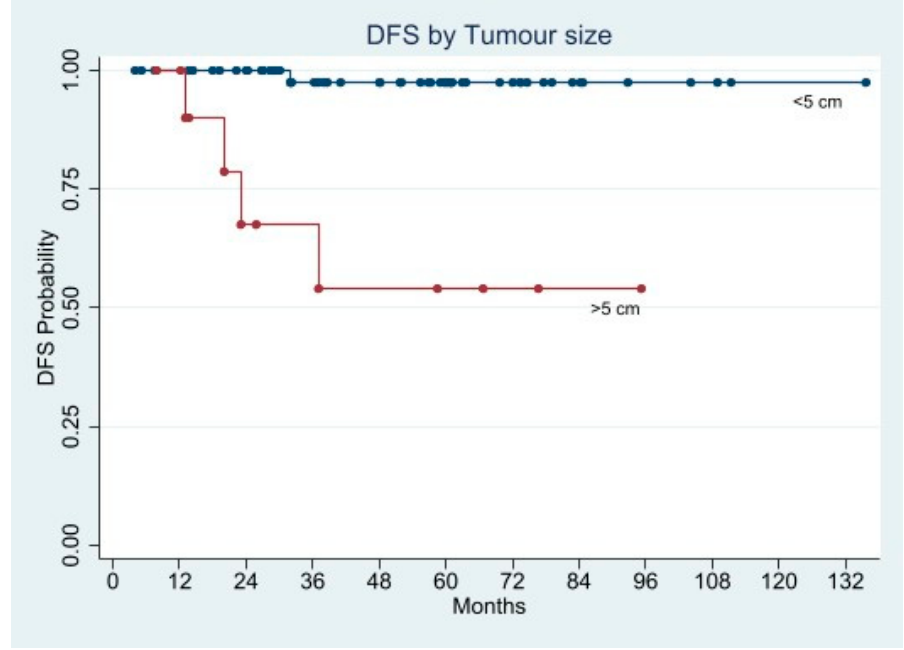
Figure 11. Disease Free Survival by Tumor size.